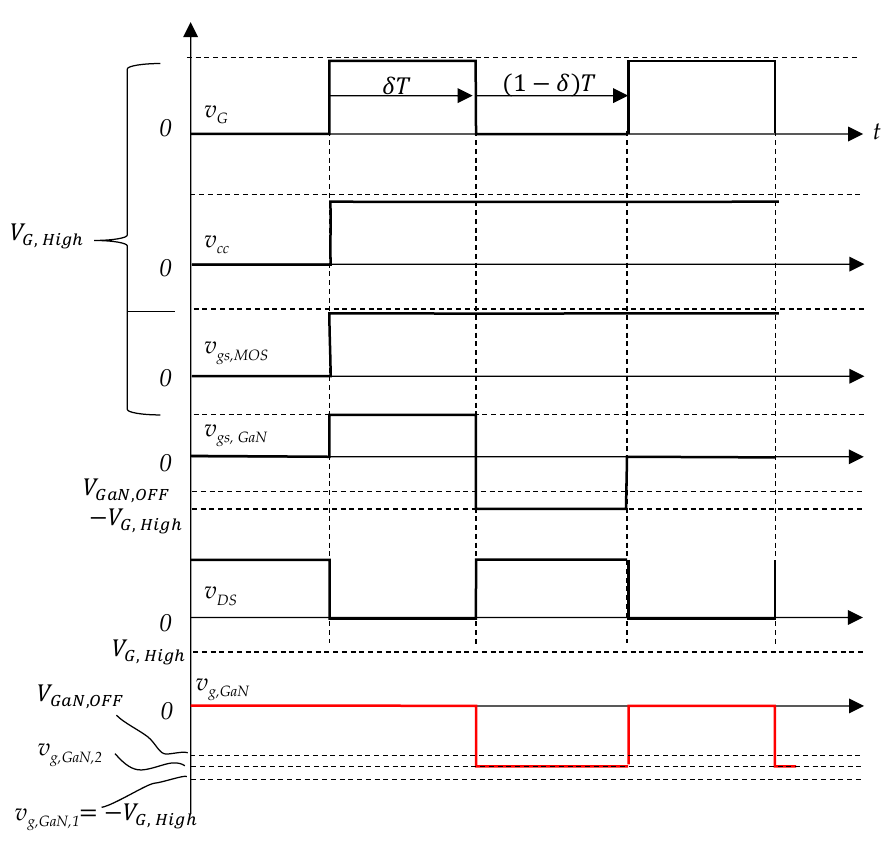
Figure 7. Voltage sequence of the GaN-switching cascode GaN HEMT power module. ( δ : duty cycle of the switching period).